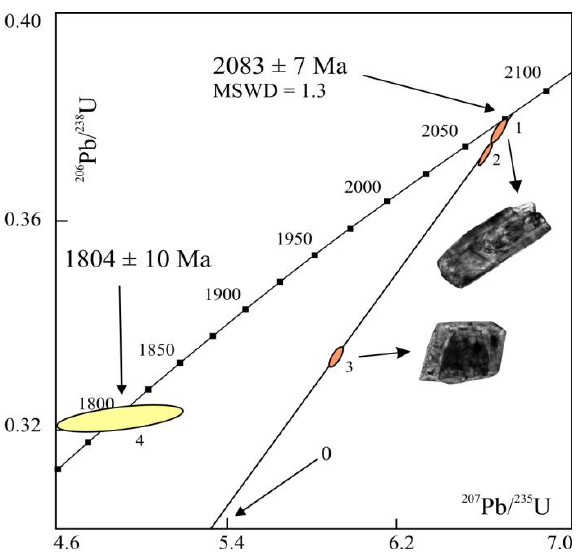
Figure 8. U–Pb plot with concordia on zircon (orange ellipses, 1–3) and rutile (yellow ellipse, 4) from a hornblendite dyke in the Pados-Tundra complex (sample Р-3).